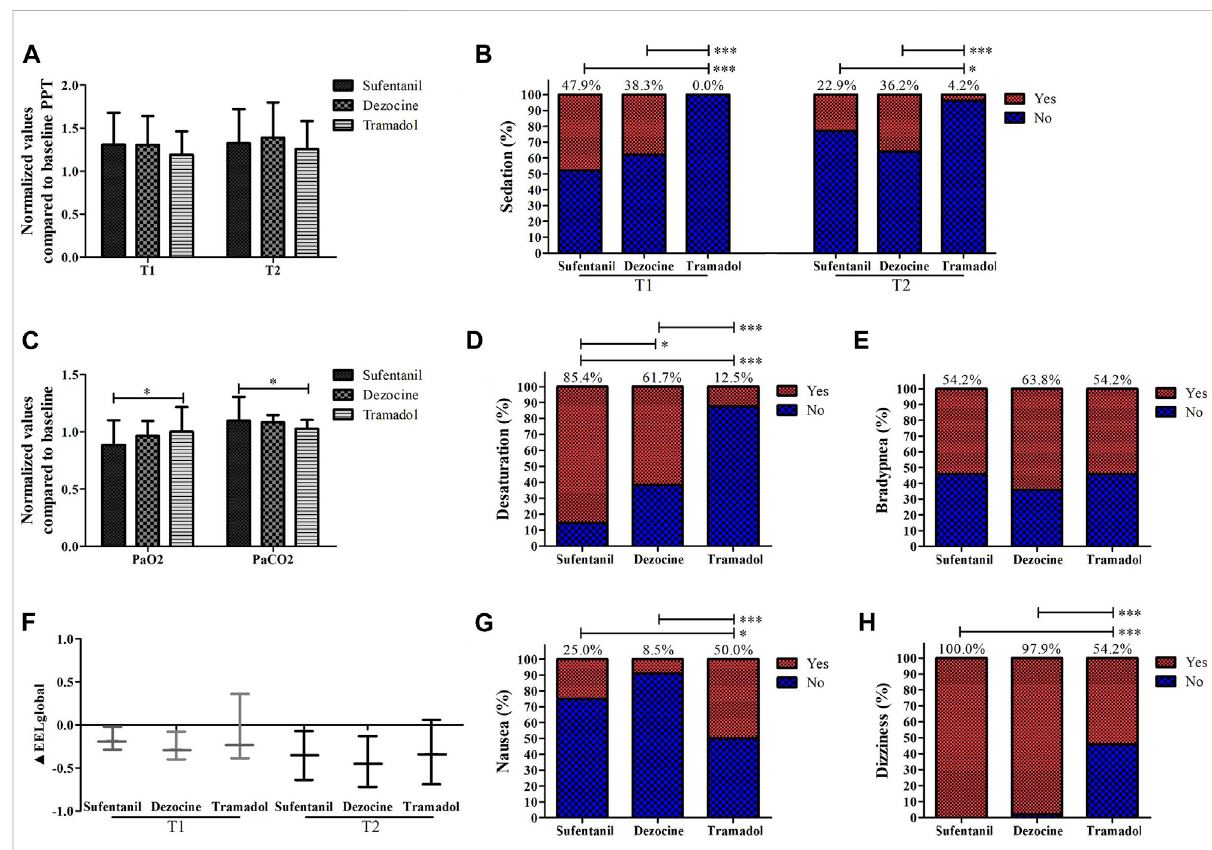
FIGURE 5 Comparisons of the values of analgesic effects (A) , sedation (B) , PaO 2 and PaCO 2 (C) , the incidences of desaturation (D) , bradypnea (E) , Δ EELI (F) ;nausea (G) anddizziness (H) inthemorninggroupforpatientsreceivingsufentanil,dezocineandtramadol.(T1,onsettimeofanalgesiceffect;T2, time of peak concentration; * p < 0.05, ** p < 0.01 and *** p < 0.001 compared with the afternoon